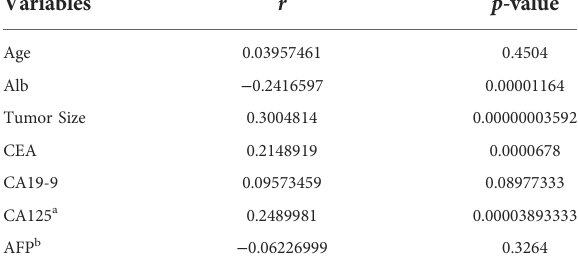
TABLE 3A Pearson ’ s correlation coef fi cient.